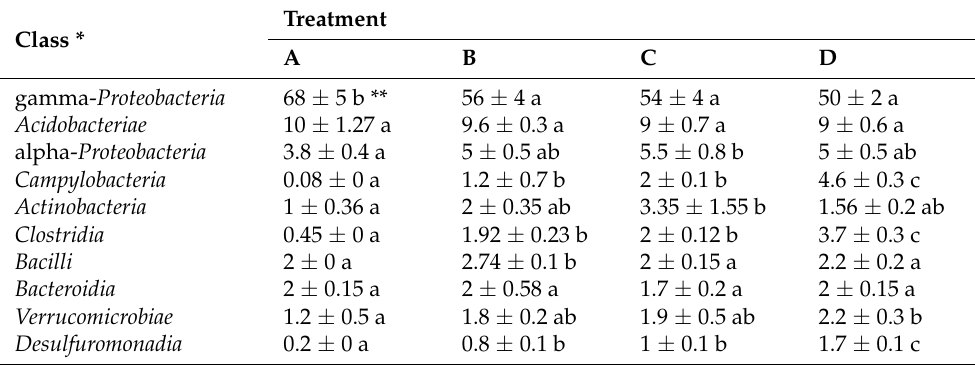
Table 6. Top ten most abundant bacterial classes present in the waste lubricating oil-contaminated soil from each